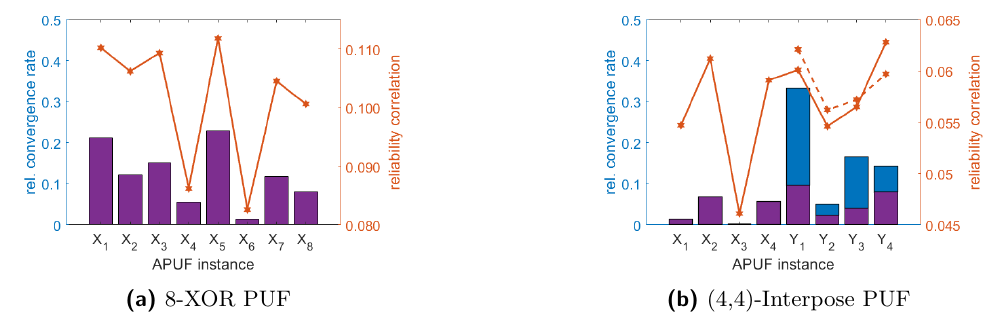
Figure 3: The left y-axis depicts the number of times a modeling attack run converged to a given APUF instance while the right y-axis shows the correlation coefficient of the delay model with the reliability information. In a) a 8-XOR APUF is used and in b) a (4,4)-iPUF is depicted. For the iPUF the correlation of the flipped delay model is depicted in dashed lines. The lower part of the stacked bar chart shows how often w y-red was learned and the top shows how often the flipped delay model w y-red was